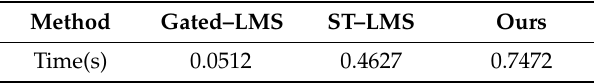
Table 1. Matlab runtime comparison of the algorithms.